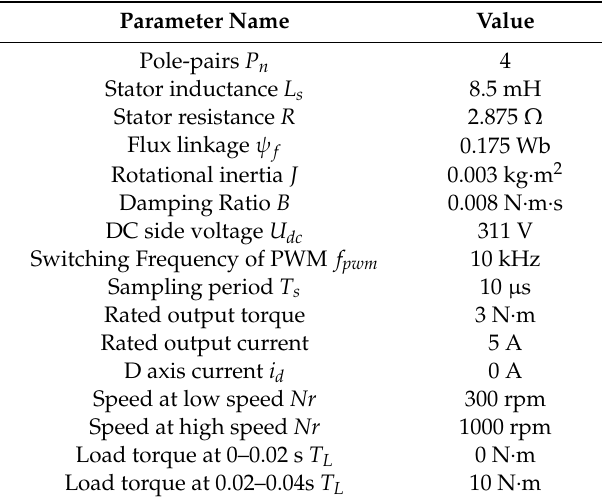
Table 1. Parameters of PMSM.